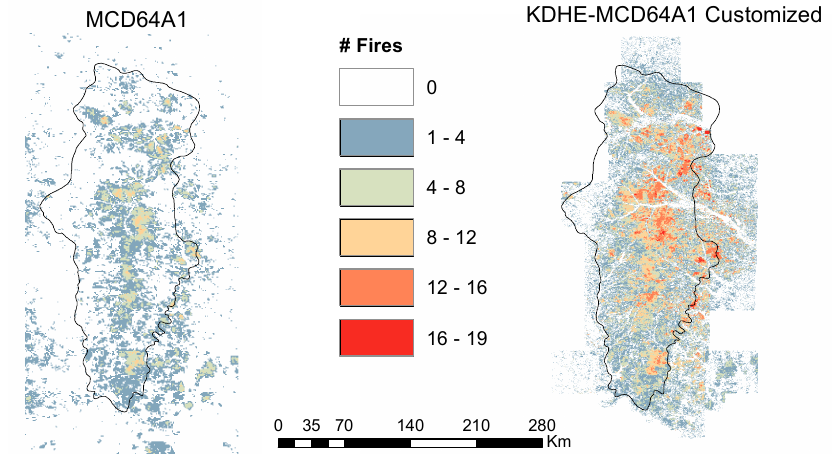
Figure 3. The number of fires over the years 2001–2019 in the Flint Hills based on MODIS MCD65A1 (left insert) and KDHE-MODIS MCD64A1 customized (right insert) with the outline of the Flint Hills ecoregion.